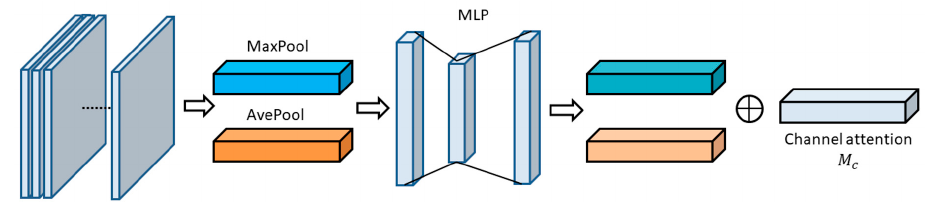
Figure 6. Channel Figure 6. Channel attention. Figure 6. Channel attention.